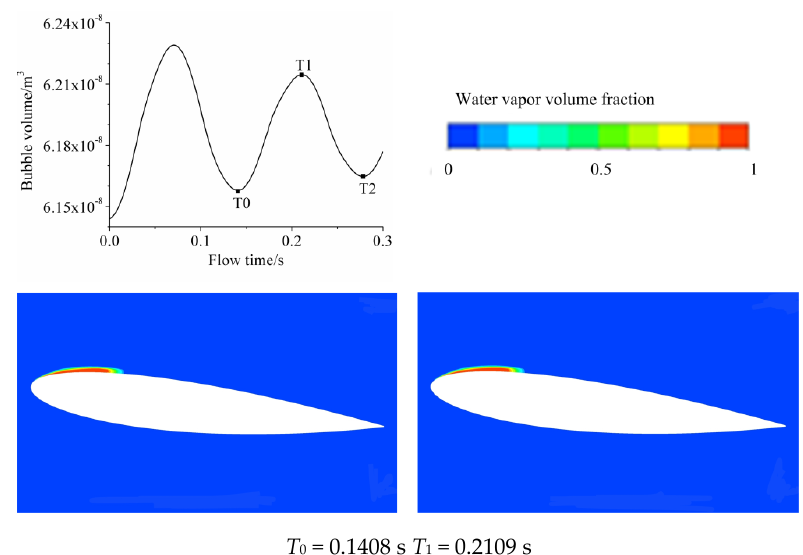
Figure 8. Bubble volume pulsation and numerical results for σ = 1.175.